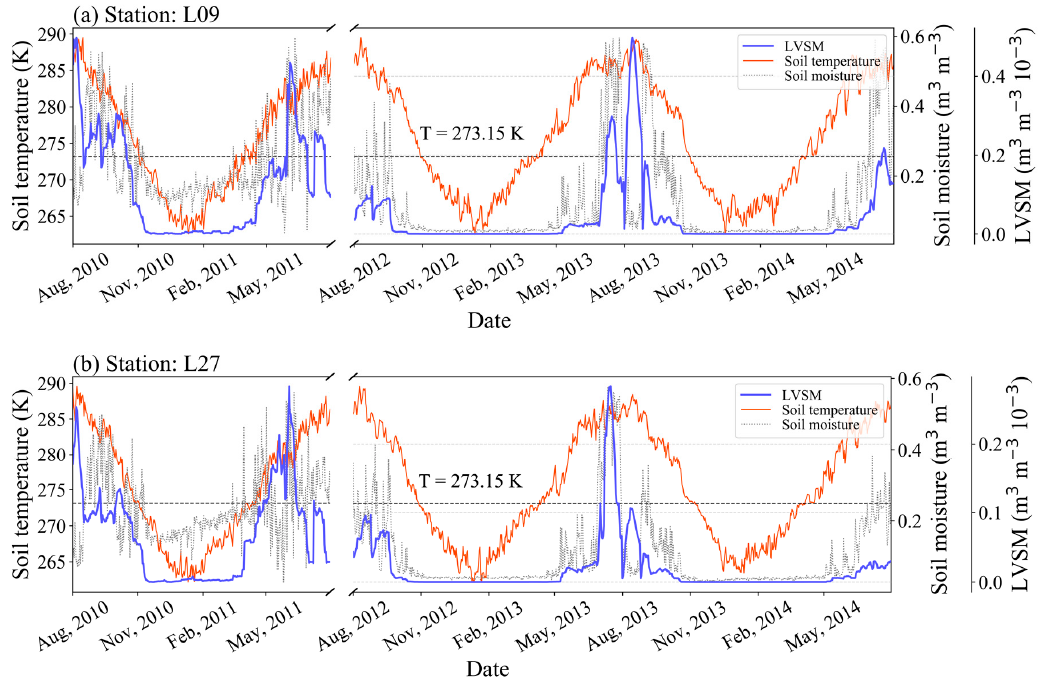
Figure 6. Seasonal variations of local variance of soil moisture (LVSM), AMSR-E, and AMSR2 soil moisture products and soil temperature products at station L9 ( a ) and L27 ( b ).